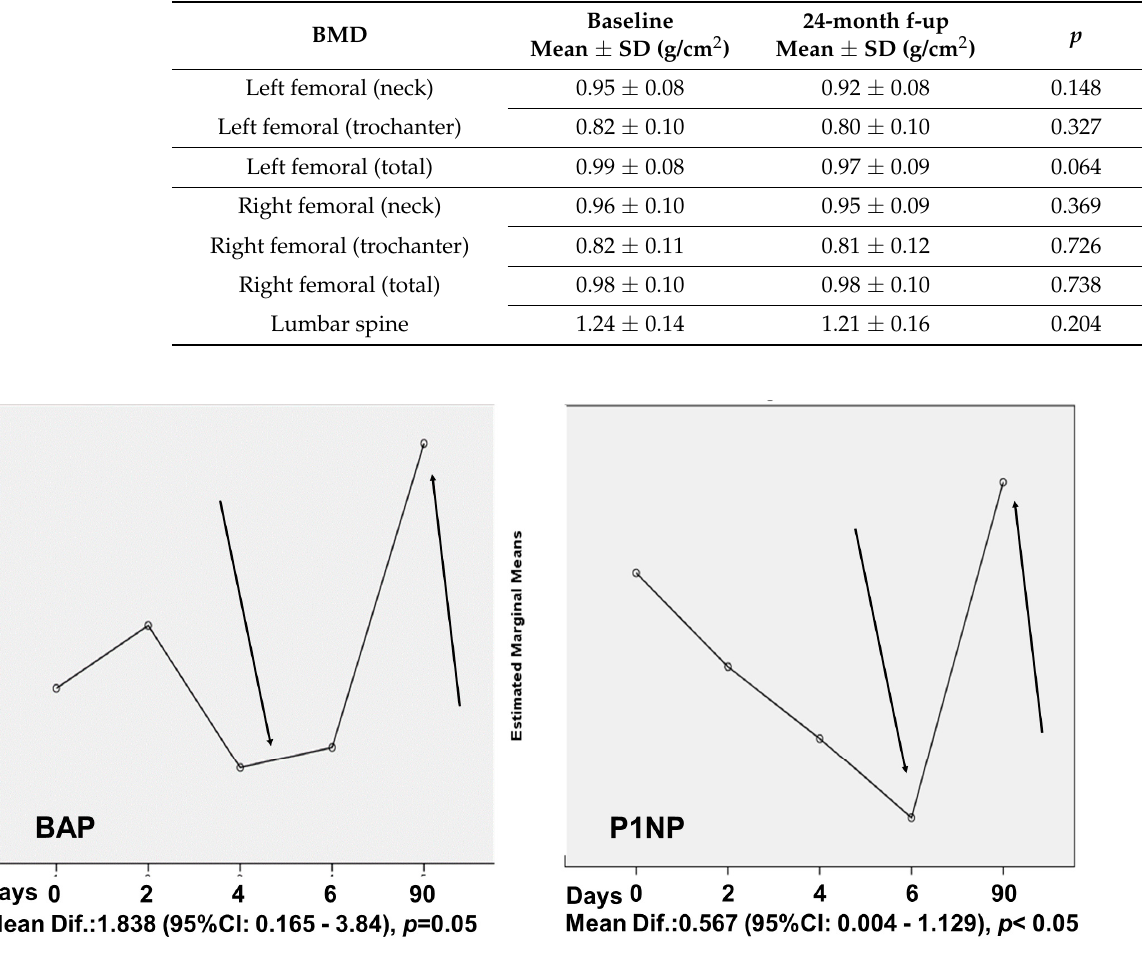
Figure 3. Bone formation markers showed an initial non - significant fall followed by a significant increase on day 90.